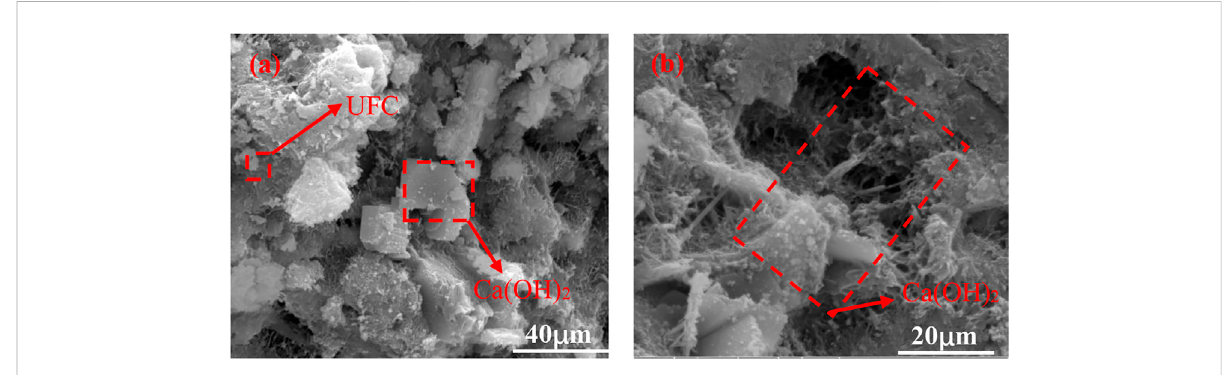
FIGURE 20 Microscopic morphology of sample S8.